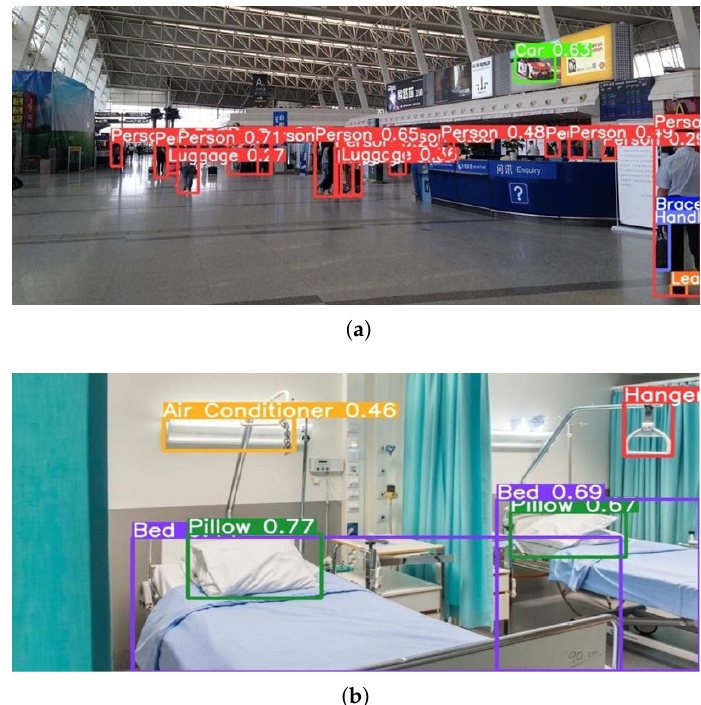
Figure 1. Incorrect object detection is performed in each environment. ( a ) A case in which the advertising panel at an airport terminal is highlighted in green and recognized as a car. ( b ) A case in which the light in a hospital room is highlighted in yellow and incorrectly recognized as an air